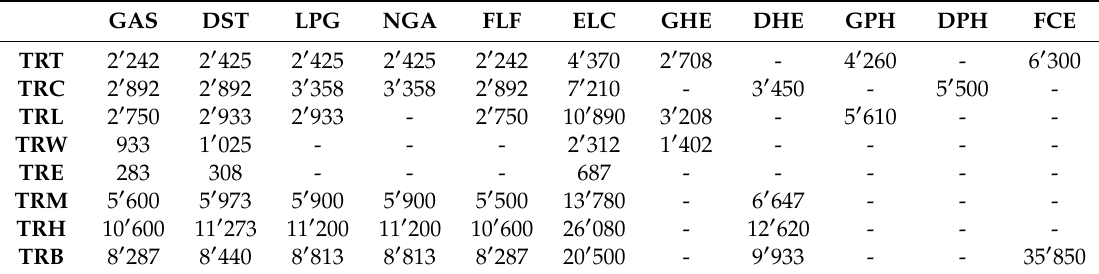
Table 7. Investment cost (in USD/year ) for the di ff erent modes / technologies in the current road transport